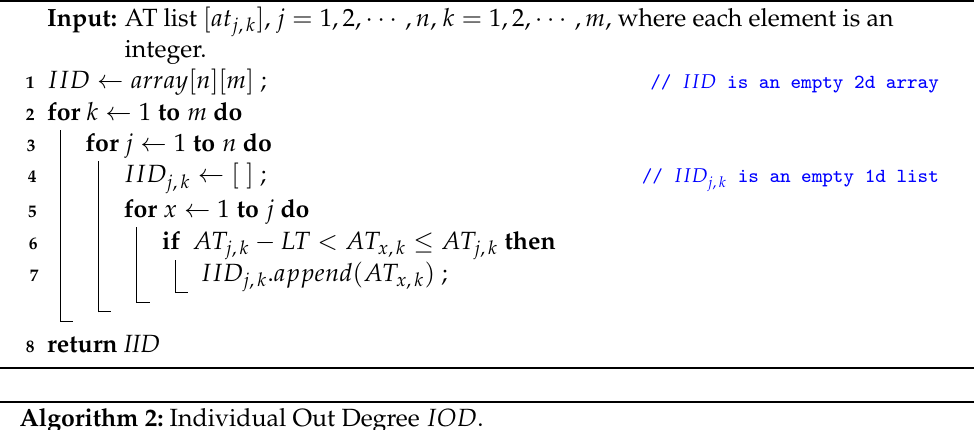
Algorithm 2: Individual Out Degree IOD .